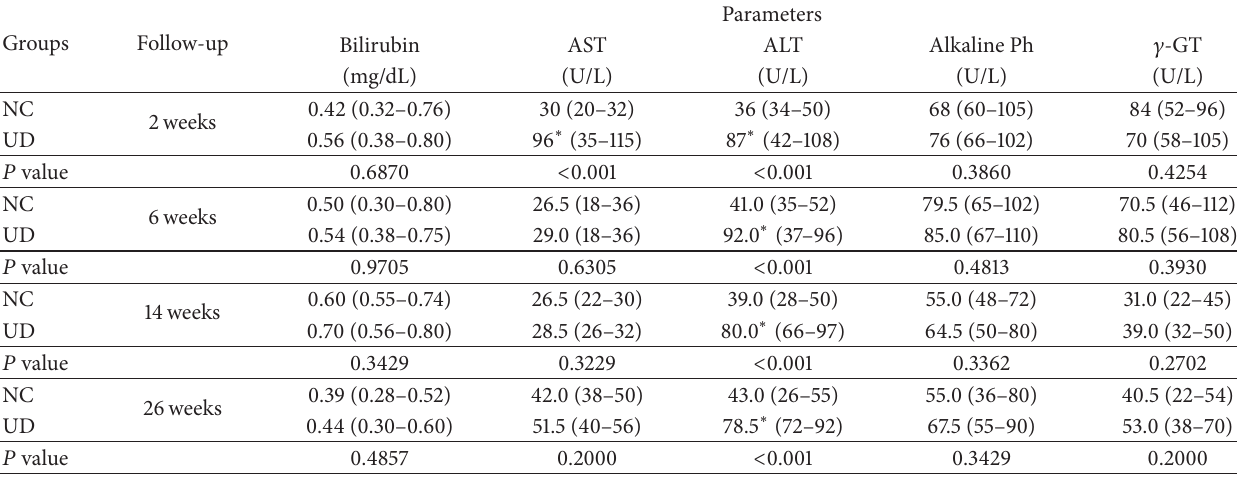
Table 1: Medians, maximum, and minimum values of parameters related to liver function of nondiabetic control and untreated diabetic rats during the various experimental follow-up